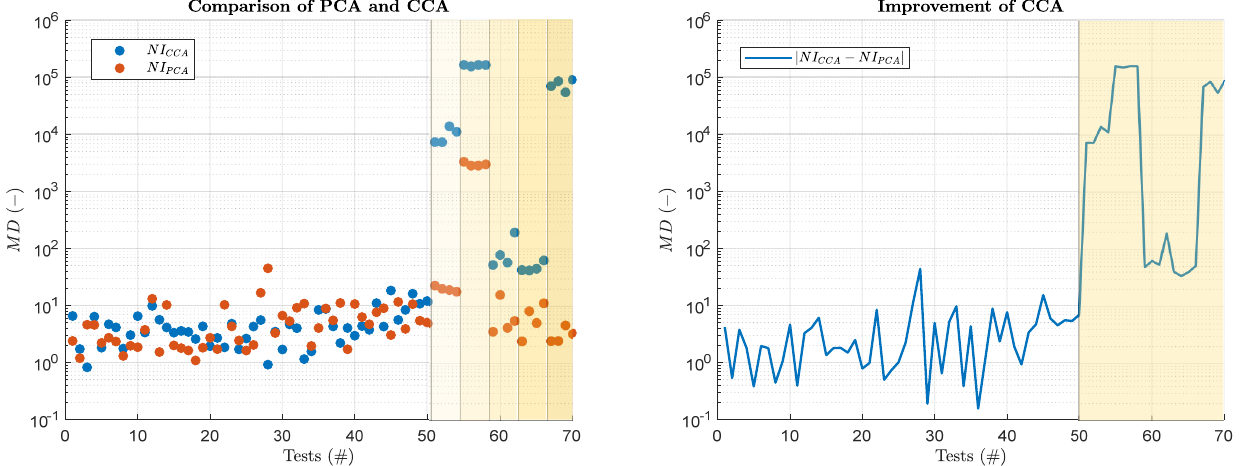
Figure 7. On the left, a comparison of the MDs calculated using a traditional PCA pre-processing and the proposed CCA pre-processing to improve the recognition of clusters. Vertical lines divide the different classes of damage. On the right, the improvement due to CCA in terms of higher separation of clusters in the new reduced space is shown. Please note that the vertical line distinguishes health and damaged classes to highlight how CCA kept the position of the reference Class 0 almost unvaried, while it increased the separation of the clusters representing the different damages.